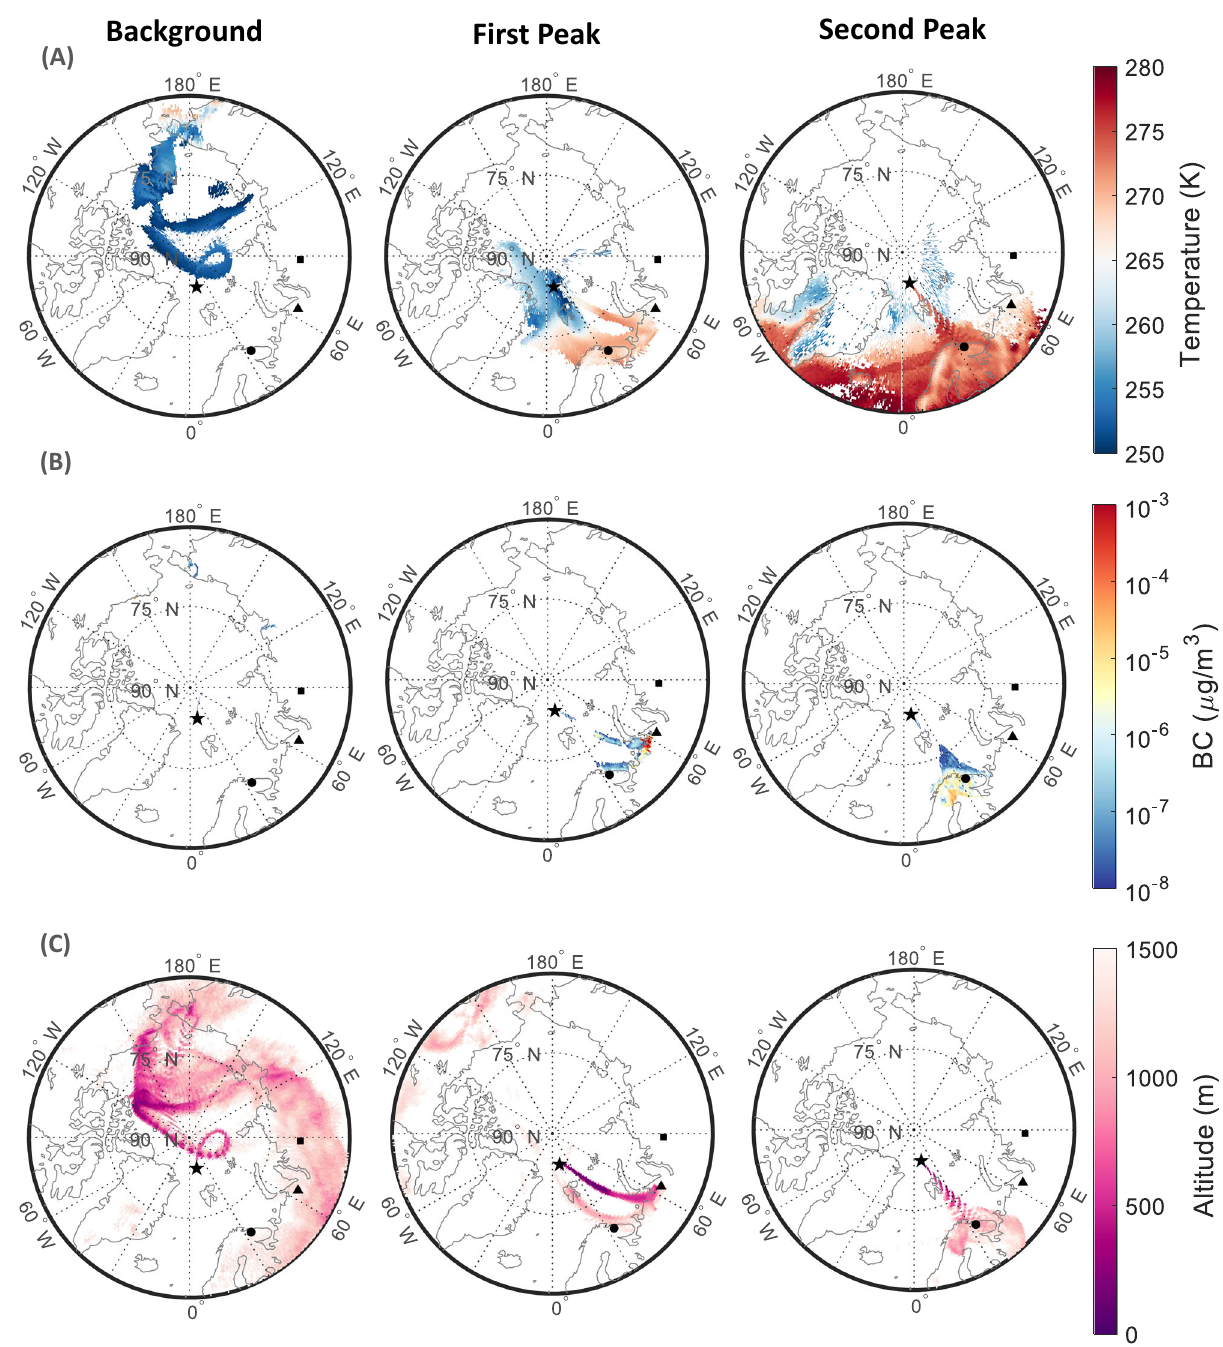
Fig. 2 | Source area, temperature, air-mass trajectories and trajectory height. A Mean temperatureofthe air-mass with simulatedparticles residing below 100m altitude, obtained from 7-day backward simulations with FLEXPART during the backgroundperiod(leftpanel), fi rstpeakoftheintrusionevent(middlepanel)and second peak of the intrusion event (right panel). B Black carbon source contribu- tion (below 100m a.g.l.), as a surrogate for anthropogenic pollution, for a passive air tracer obtained from 7-day backward simulations with FLEXPART during the backgroundperiod(leftpanel), fi rstpeakoftheintrusionevent(middlepanel)and second peak of the intrusion event (right panel). Inserts of B are shown in Fig.S5.